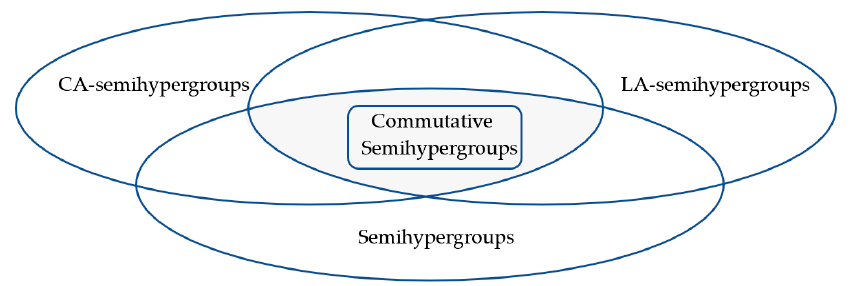
Figure 2. The relationships among some algebraic systems.